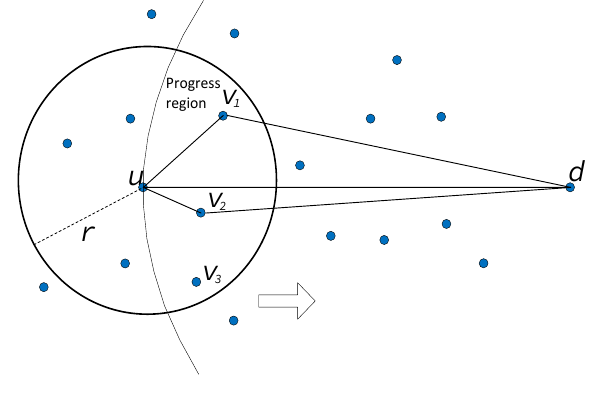
Figure 1. A geographic greedy forwarding step by which the node u must choose a next relay neighbour from the set { v 1 , v 2 or v 3 } toward the destination d